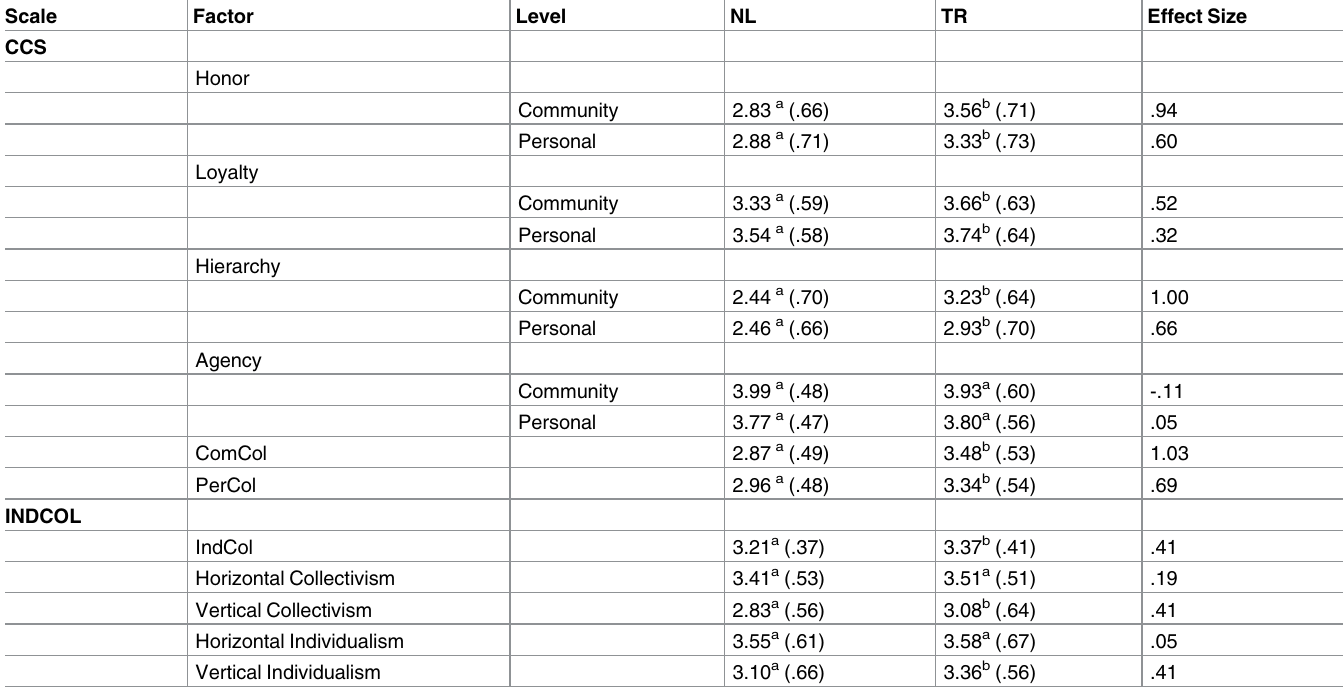
Table 6. Means (SD) and effect sizes (Cohen’s d) of a priori dimensions and aggregate indexes of CCS and INDCOL’95 dimensions. Scale